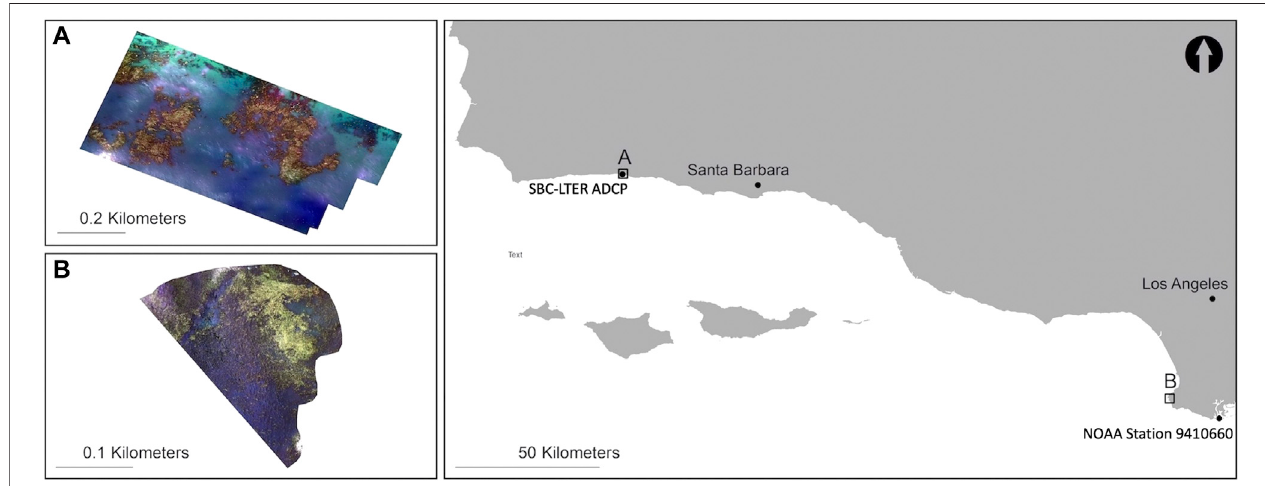
FIGURE1| SantaBarbara,Californiastudysite:ArroyoQuemado (A) withassociatedSBC-LTERADCPandPalosVerdes,Californiastudysite:HoneymoonCove (B) with associated NOAA station 9410660.